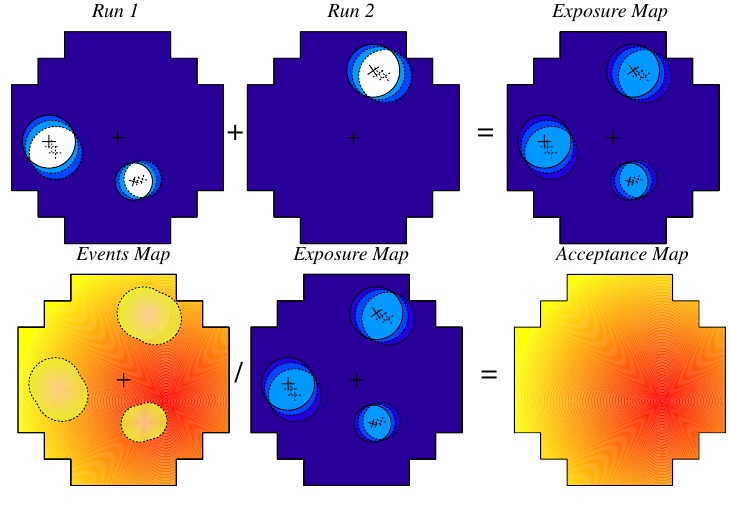
Figure 9. 2D acceptance determination. ( Top ) Determination of the exposure map by stacking of maps from individual runs. ( Bottom ) Determination of the final acceptance map from the ratio of the event maps to the exposure map. Reproduced from